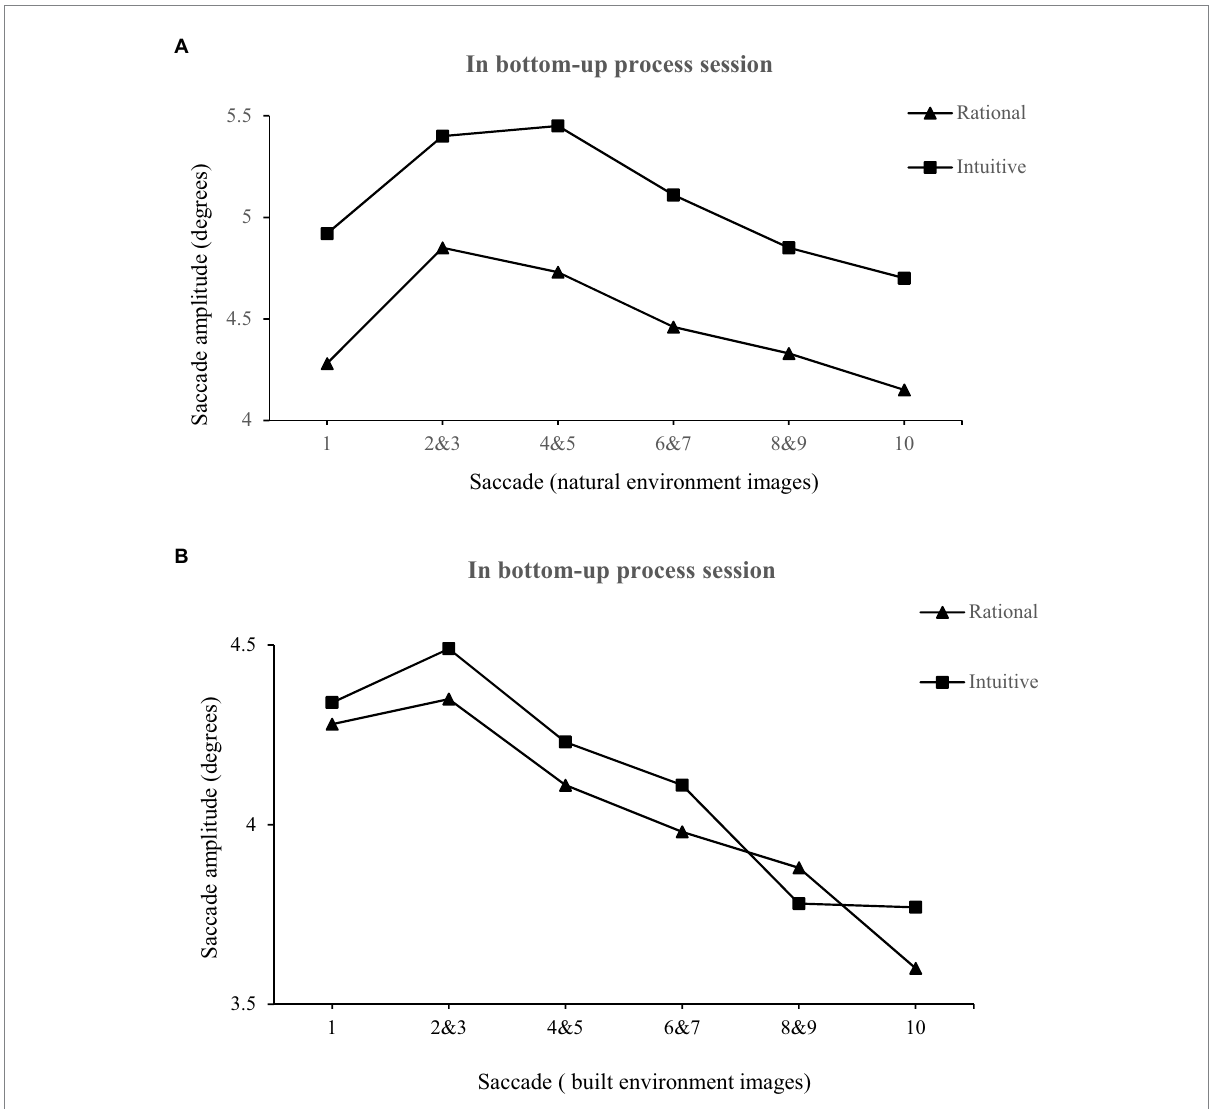
FIGURE 2 Saccade length initially increases and then decreases over the viewing interval in a freely browsing